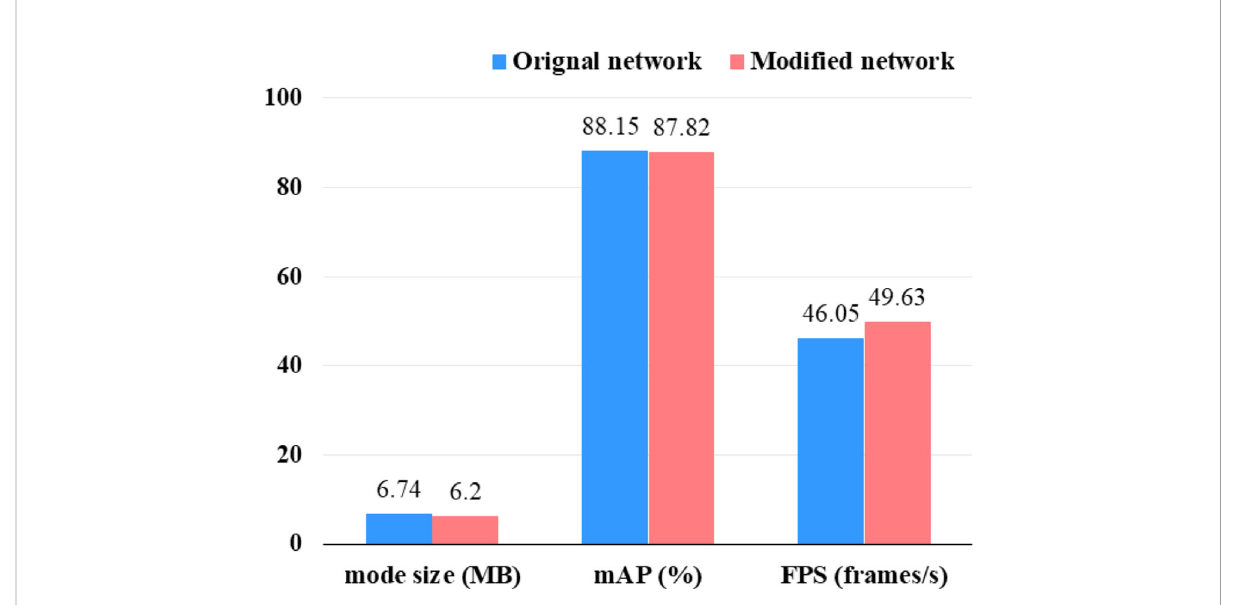
FIGURE 6 Comparison of the original and modi fi ed network